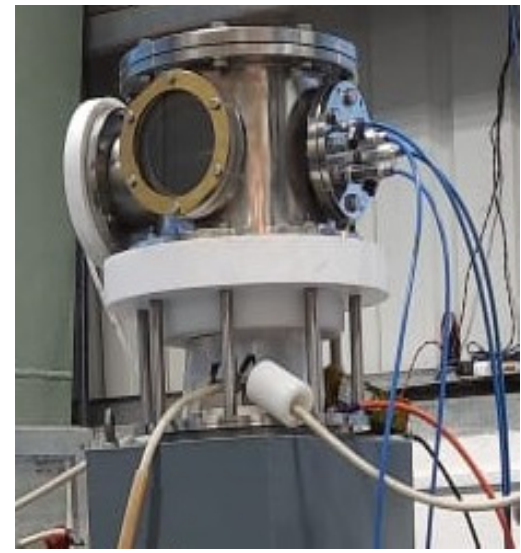
Figure 9. Correction factor δ Vs d/r for hemi-sphere profile.